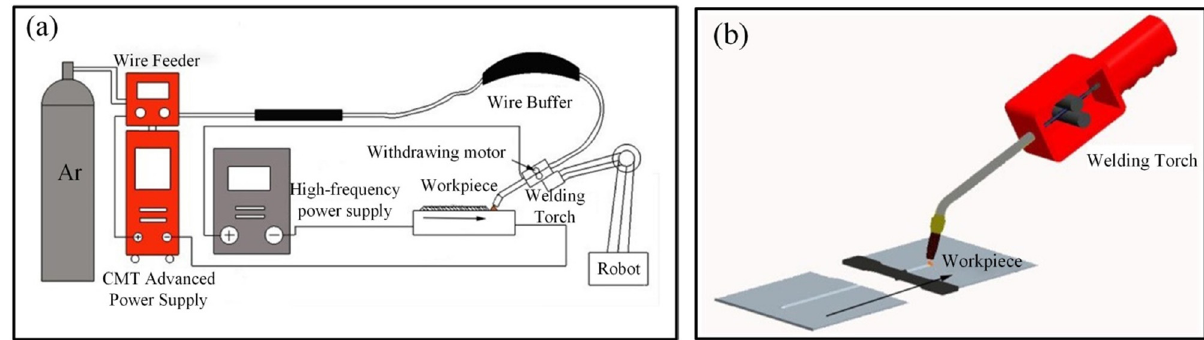
Figure 2: The experimental set - up of AC CMT advanced supply coupled with high - frequency power supply: ( a ) AC CMT advanced supply and high - frequency generator and ( b ) welding torch [ 16 ] .